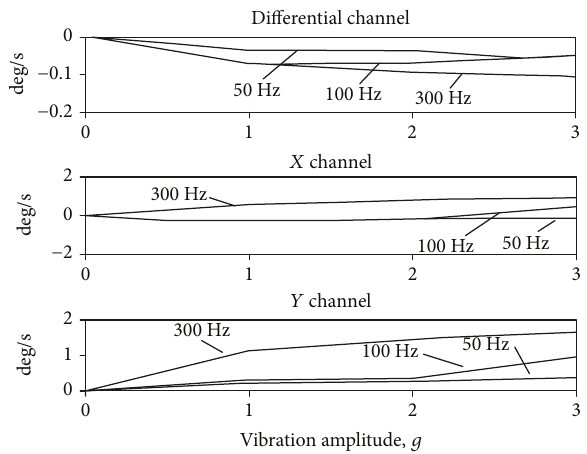
Figure 10: Bias change vs. acceleration amplitude under sinusoidal vibration of di ff erent